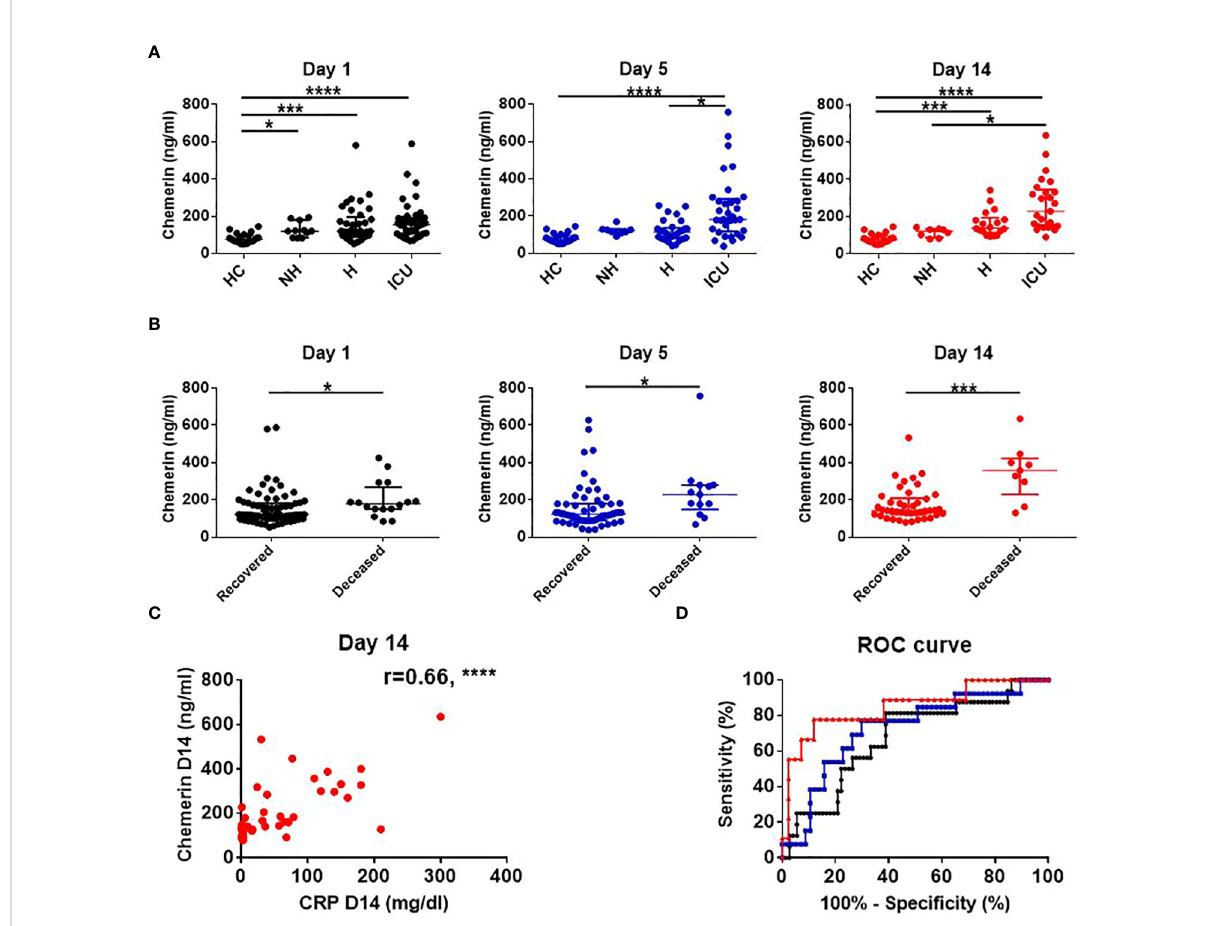
FIGURE 2 Chemerin assessment and its association with risk of death and in fl ammation. (A) Time course assessment of chemerin concentration in plasma of healthy controls and subgroups of COVID-19 patients. Of note, data from HC were obtained at only one time point. Data are presented as median with interquartile range and statistical analysis was performed using Kruskal-Wallis test followed by Dunn ’ s post-hoc test. (B) Comparison of plasma chemerin levels in recovered versus deceased COVID-19 patients. Data are presented as median with interquartile range and statistics analysis was performed using Mann-Whitney test. (C) Prediction of mortality by chemerin concentration at day 1 (black), day 5 (blue) and day 14 (red) using a ROC analysis (D) Correlation between chemerin concentrations and in fl ammation, estimated by C-reactive protein (CRP) concentration at day 14. The r corresponds to the Spearman coef fi cient for non-parametric correlation. Non-hospitalized (NH), n=11; hospitalized non-intensive care unit (H), n=37; hospitalized in intensive care unit (ICU), n=40; healthy controls (HC), n=21. *: p<0.05; ***: p<0.001; ****: